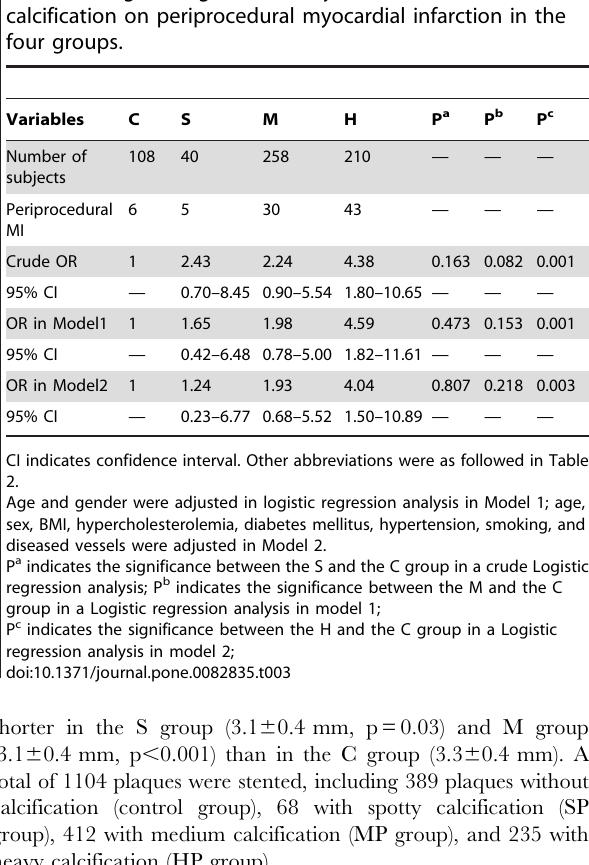
Table 5. Logistic regression analysis of the effect of calcification on periprocedural myocardial infarction according to the tertiles of the coronary artery calcium score.